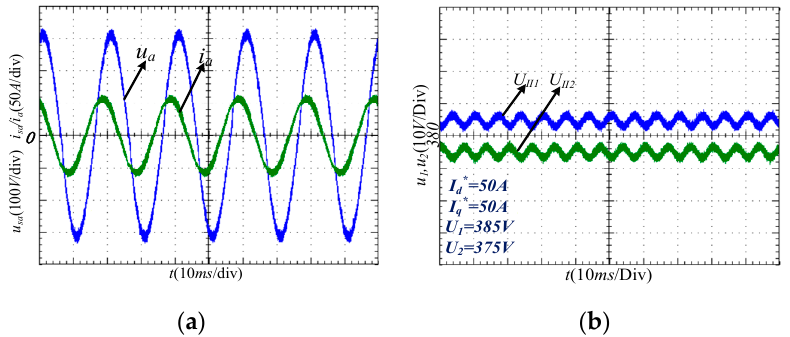
Figure 16. Waveforms without balancing control. ( a ) Waveforms of 𝑢 𝑎 , and 𝑖 𝑎 . ( b ) Waveforms of U II1 and U II2.